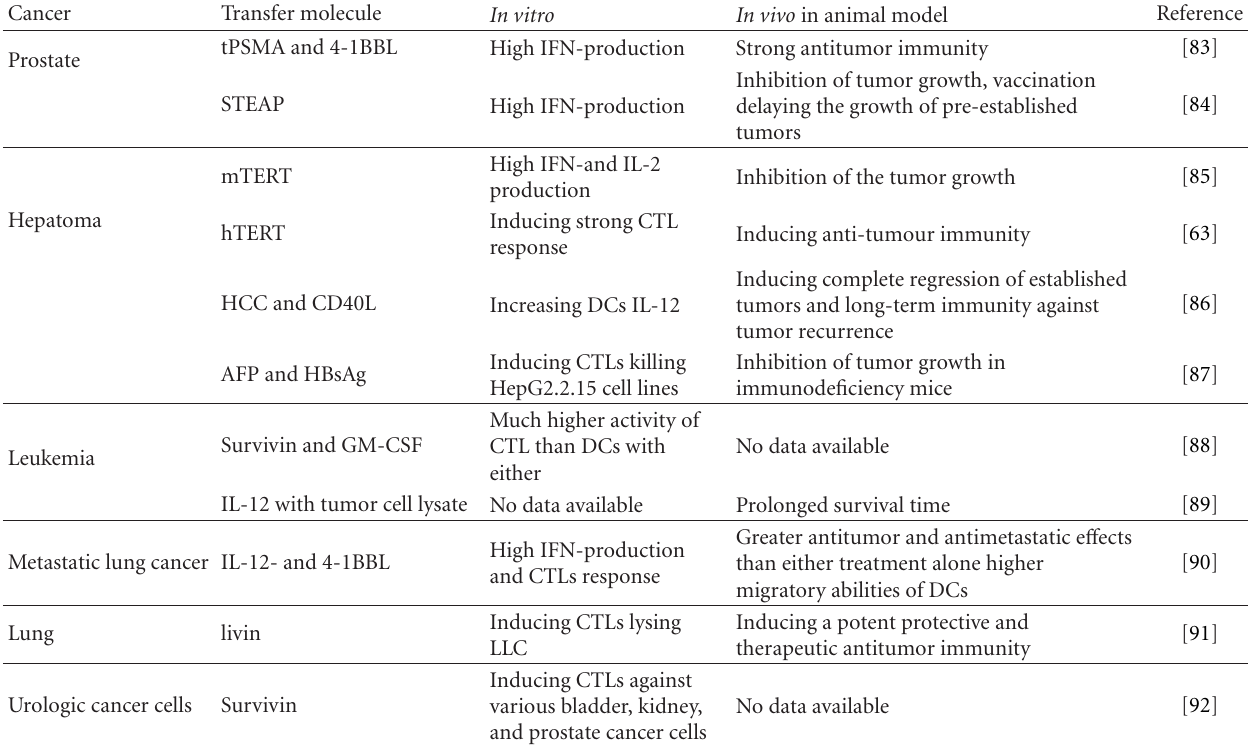
Table 1: Overview of recent studies using Ad vectors for gene transfer in